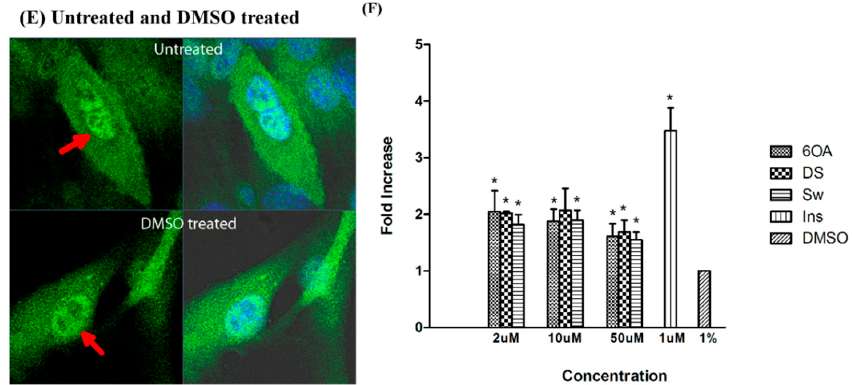
Figure 6. The compounds affected the distribution of GLUT4 proteins and facilitated glucose uptake in the C2C12 muscle cells. The GLUT4 proteins were visualized via the green fluorescent FITC labeled-GLUT4 antibody. The blue fluorescence shows the location of the nucleus stained by DAPI. The treatment of cells with ( A ) 2 µM 6OA; ( B ) 2 µM DS; ( C ) 2 µM Sw or ( D ) 200 nM insulin resulted in the diminished presence of GLUT4 in the nucleus and intensified presence near the plasma membrane compared with ( E ) 1% DMSO treated or untreated cells. The white arrows show the presence of GLUT4 near the plasma membrane, and the red arrows show the presence of GLUT4 within the nucleus. The figures denote the time lapse (m = minutes) after treatment. The images were captured using a LSM710 laser scanning microscope with a 63X oil immersion objective (Carl Zeiss, Oberkochen, Germany); ( F ) The amount of 2-NBDG uptake in the cells after treatment 6OA, DS and Sw or insulin was quantified at OD 510 nm. The fold increase was plotted against the treated concentration of natural compounds. The symbol * denotes a significant difference at p < 0.05 compared with DMSO (Tukey’s test, n = 6), DMSO = 1.